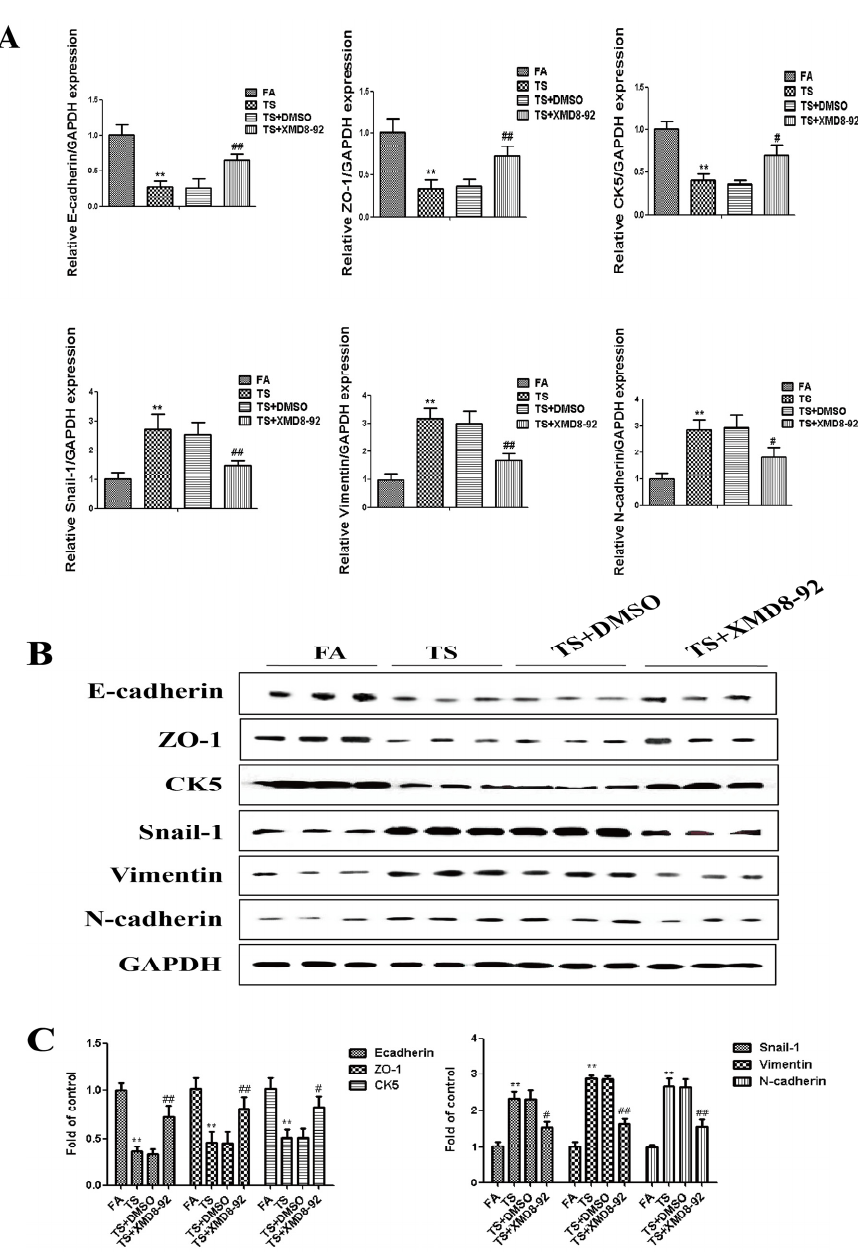
Figure 4. ERK5 suppression reversed tobacco smoke ‐ induced gastric epithelial ‐ mesenchymal transition alterations in mice. ( A ) qRT ‐ PCR analyses of E ‐ cadherin, ZO ‐ 1, CK5, Snial ‐ 1, Vimentin, and N ‐ cadherin mRNAs; ( B ) Western blotting analyses of E ‐ cadherin, ZO ‐ 1, CK5, Snial ‐ 1, Vimentin, and N ‐ cadherin proteins; ( C ) Densitometric analyses of Western blotting. Data are expressed as mean ± SD. ** p < 0.01, compared with FA control; # p < 0.05, compared with TS; # p < 0.05, ## p < 0.01, compared with TS. FA = filtered air; TS = tobacco smoke.